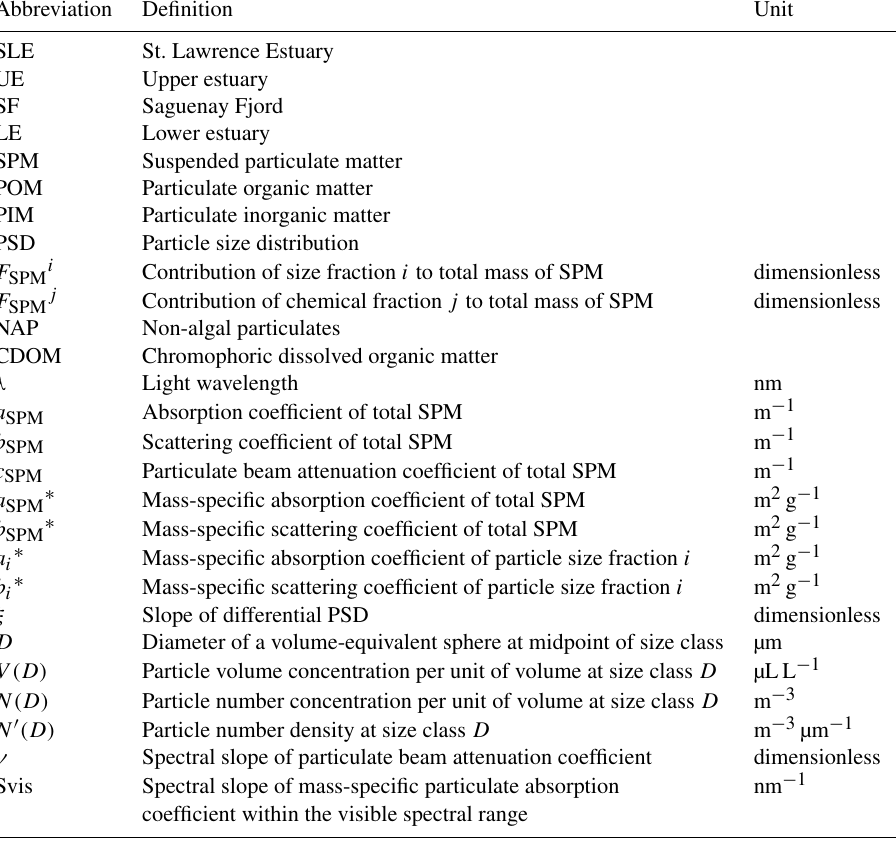
Table 1. Summary of